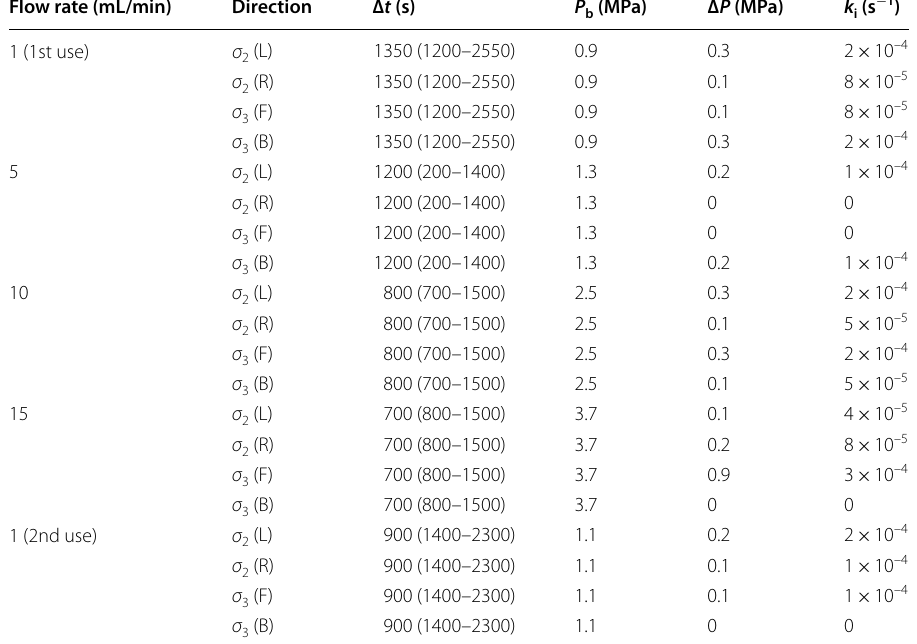
σ x (y) in the second column denotes the outlet face, y (R: right face, L: left face, F: front face, B: back face) subjected to the principal stress, σ x (x: 1, 2, 3)